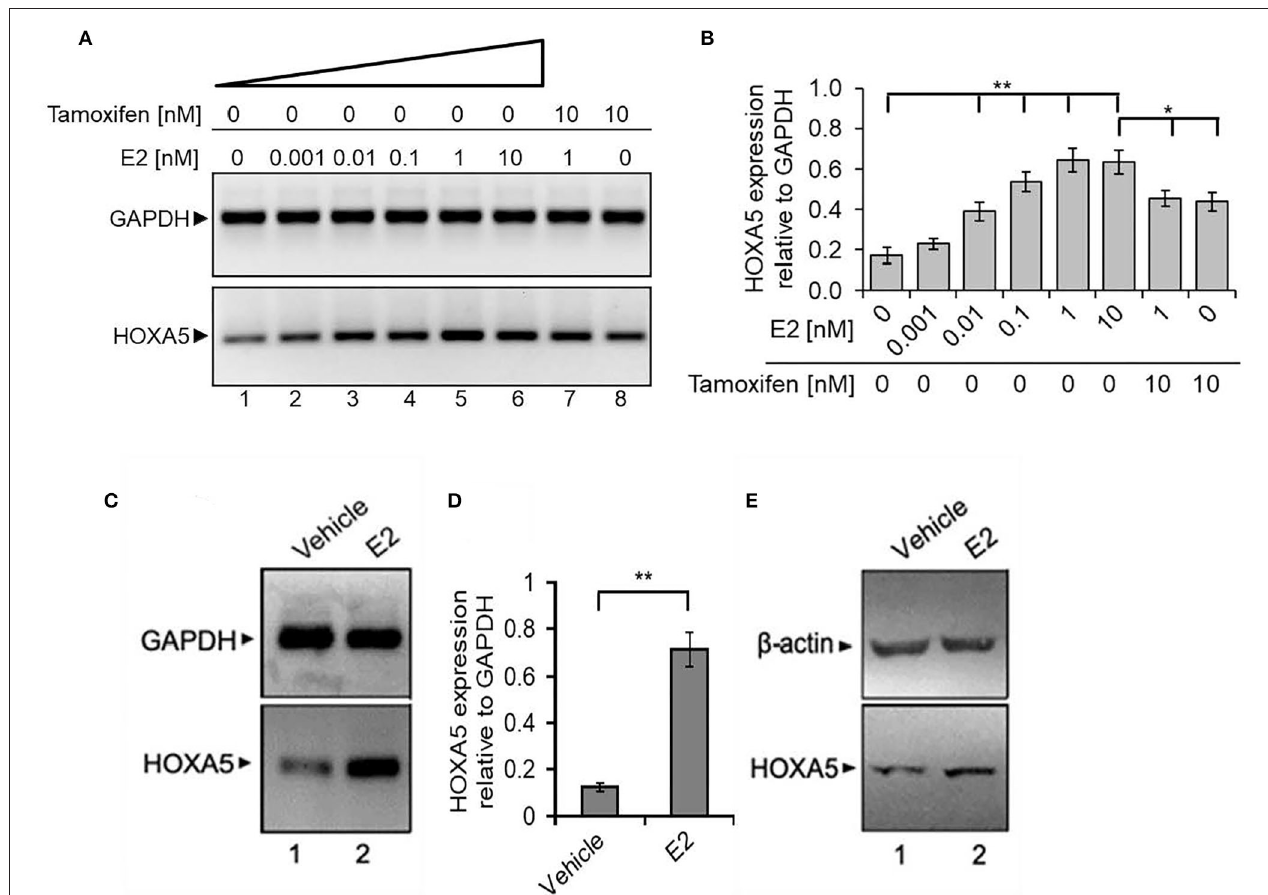
FIGURE 4 | E2-induced expression of HOXA5. (A,B) E2-induced expression of HOXA5 in MCF7 cells. MCF7 cells (grown in phenol red–free media and charcoal-stripped FBS) were treated with varying concentrations (0–10nM) of E2 for 6h in the presence and absence of 10nM tamoxifen. RNA analyzed by RT-PCR using primers specific to HOXA5 and GAPDH (control). An agarose gel analysis picture of the PCR products is shown in (A) , and qPCR analysis (expression of HOXA5 relative to GAPDH) is in (B) . Bars indicate averages ± standard errors ( n = 3). **denotes p < 0.0001 compared to untreated controls; *denotes p < 0.001 compared to 10nM E2. (C–E) Effects of E2 on HOXA5 expression in OVX rats in vivo . OVX female rats were treated with E2 (5 µ g for 24h) or vehicle (peanut oil/saline). RNA and protein were isolated from the mammary glands of the control and E2-treated animals. RNA was analyzed by RT-PCR using rat-specific primers for HOXA5 (quantification in D ); GAPDH was used as a loading control. Each experiment was repeated thrice with three parallel replicates. Bars indicate averages ± standard errors, **denotes p < 0.0001 compared to vehicle control. Western blot analysis of the HOXA5 protein levels from the protein samples obtained from control, E2-treated mammary gland tissues of animals are shown in (E) . β -actin was used as the loading control. Each experiment was repeated at least thrice ( n =